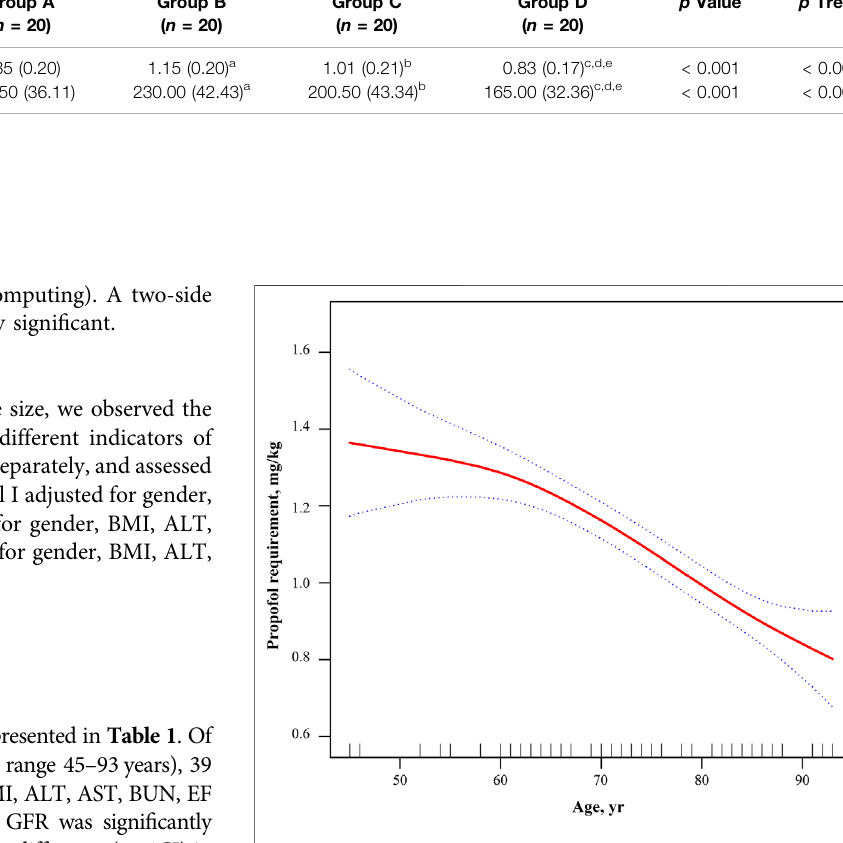
FIGURE 1 | Adjusted dose-response relationship between propofol requirement and age. Adjusted for gender, BMI, ALB, ALT, and GFR. BMI, body mass index; ALB, albumin; ALT, alanine aminotransferase; AST, aspartate aminotransferase; GFR, glomerular fi ltration